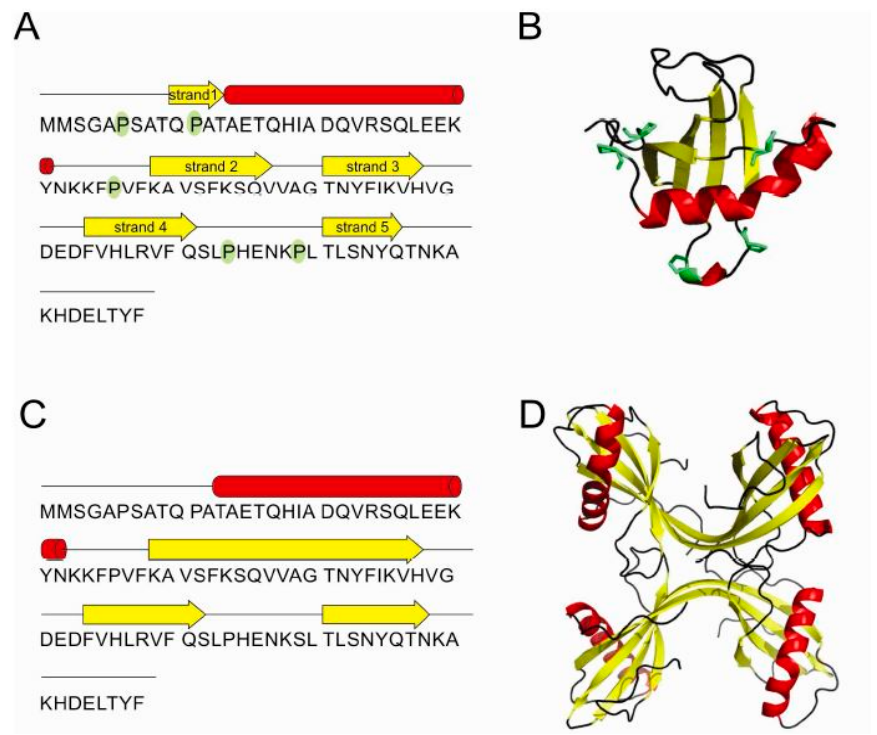
Figure 5. Stefin B—schematic representation of secondary structure elements ( A ) and the 3D structure of monomer (PDB id: 1STF) [36] ( B ). Schematic of secondary structure elements ( C ) of the two domain-swapped dimers building-up the tetramer (PDB id: 2OCT) [19] ( D ). All five prolines are highlighted in green in the monomer.